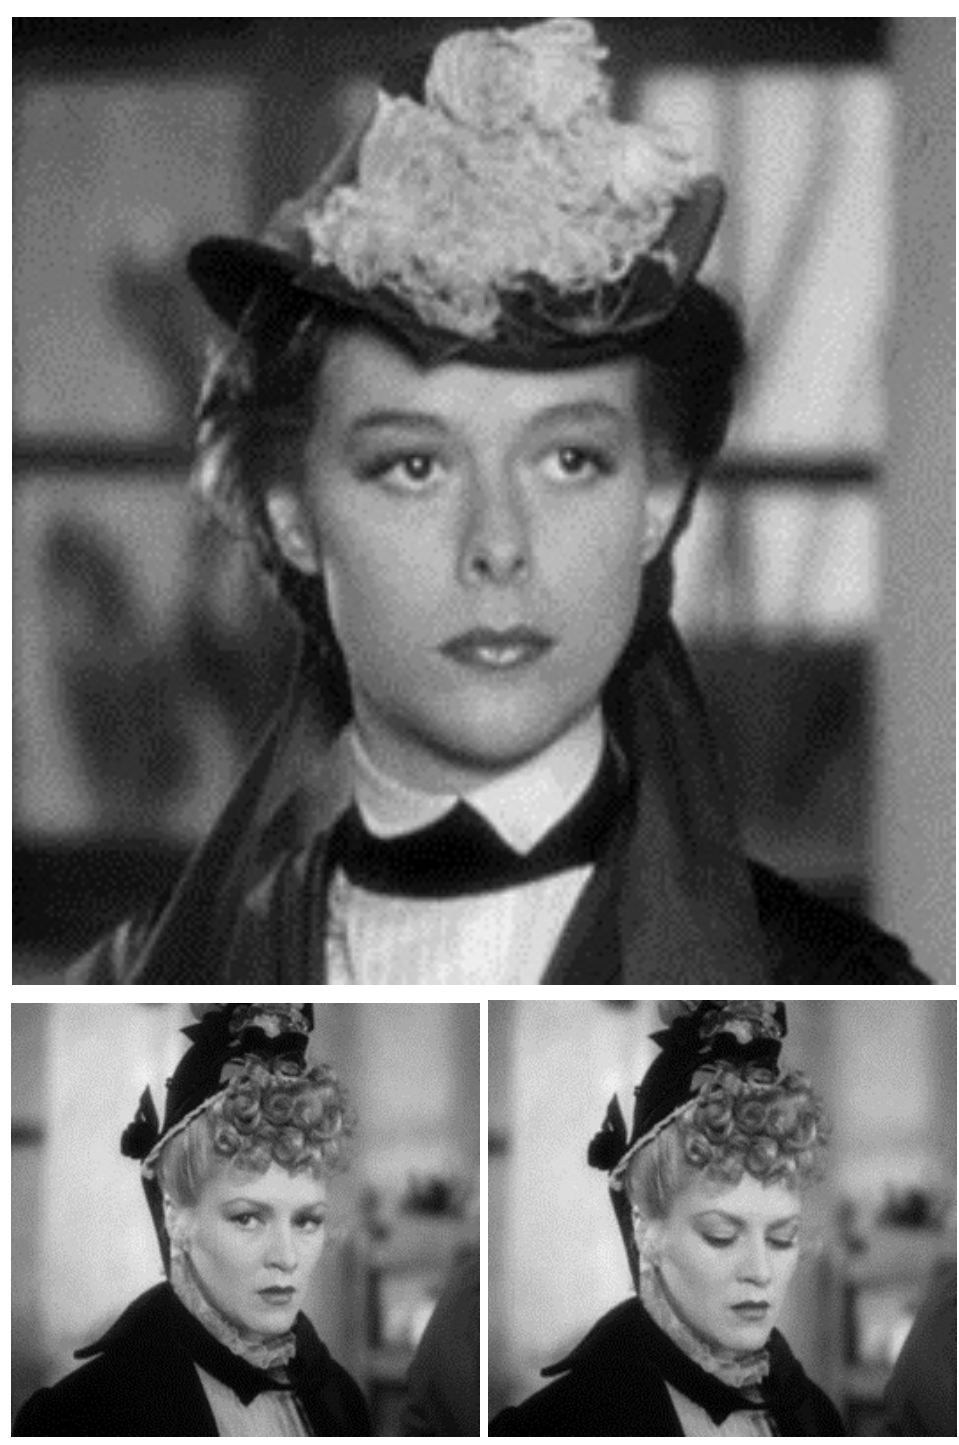
Figure 5: Notice the dominance and hostility of Lucy Mallory’s gaze, as Dallas lowers her eyes in submission to social